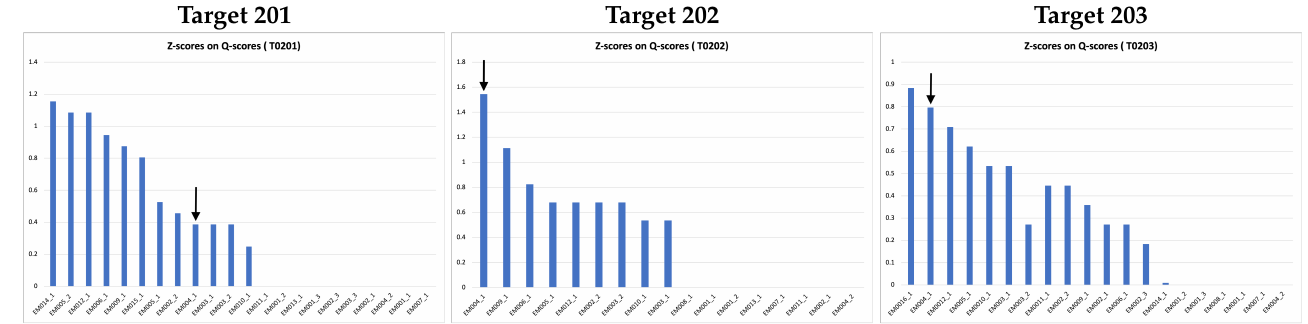
Figure 9. Z-scores on Q-scores for ligand of all the models submitted to 2021 Ligand Model Challenge. The pointed arrow represents our